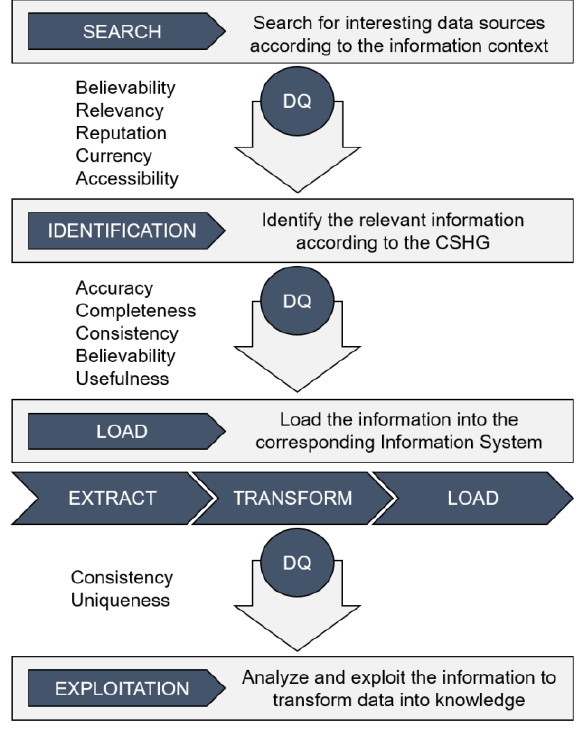
Figure 10. The SILE